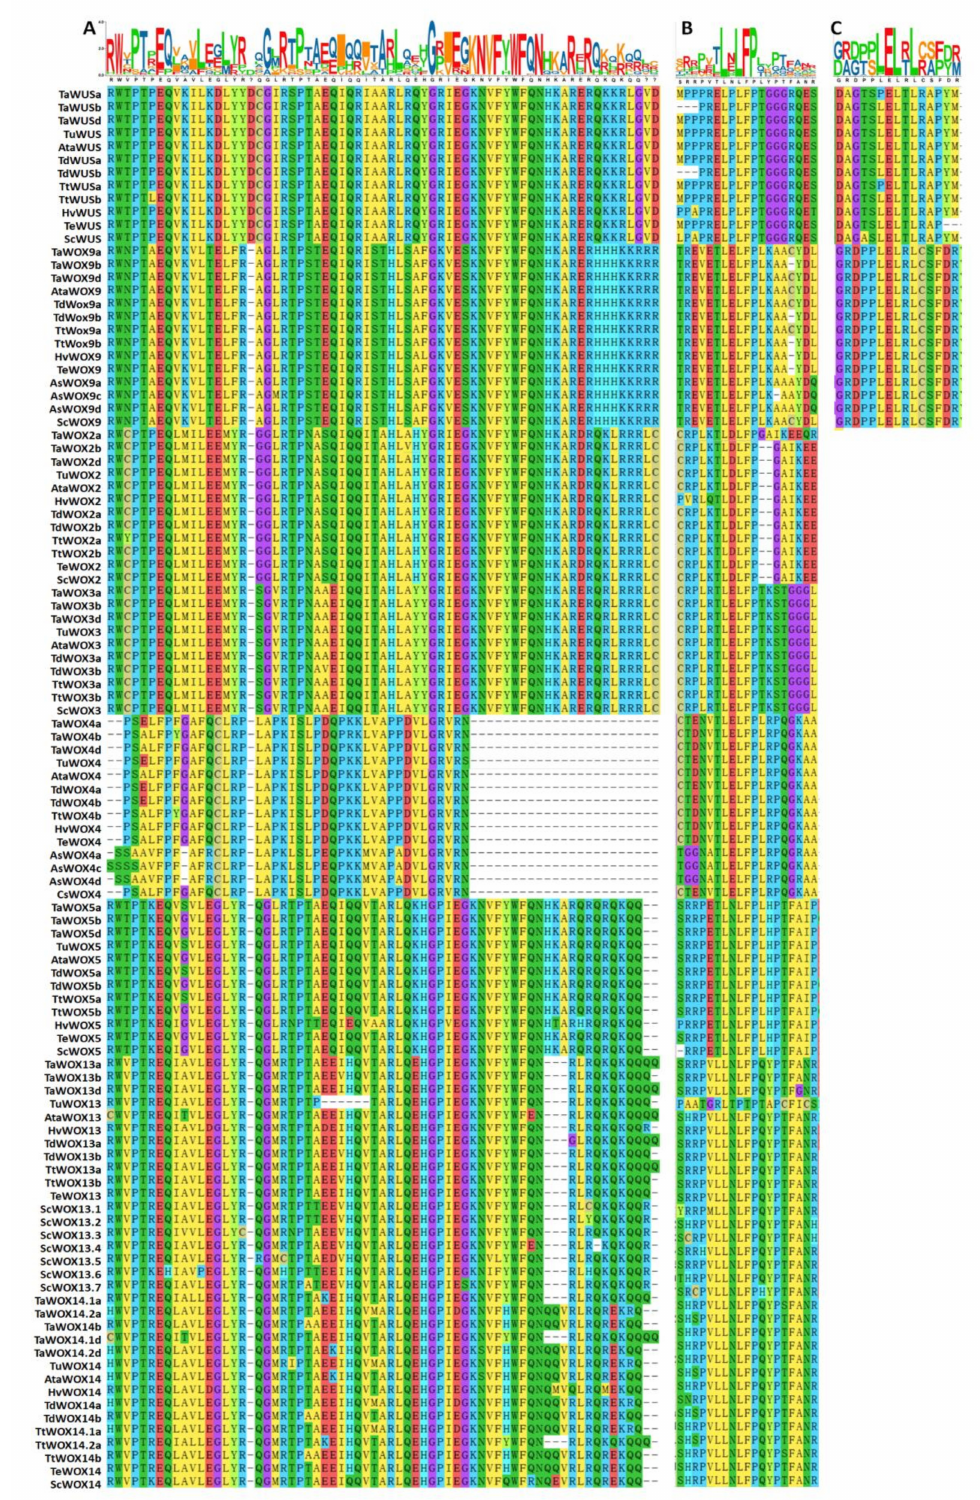
Figure 7. Alignment of WOX homeodomains from WUS clade of nine Triticeae species. Phyloge- netic alignment of homeodomain sequences was conducted by ClustalW algorithm using MEGA X software. LOGO of protein sequences represent the relative frequency of an amino acid at the corresponding position, and the content of the aligned sequences at a position in bit (max. 4.322 bit for proteins, i.e., log220). Multiple sequence alignment among the HOX homeodomain ( A ), WUS-motif ( B ) and EAR domain ( C ) of WOX proteins in WUS clade in these nine Triticeae